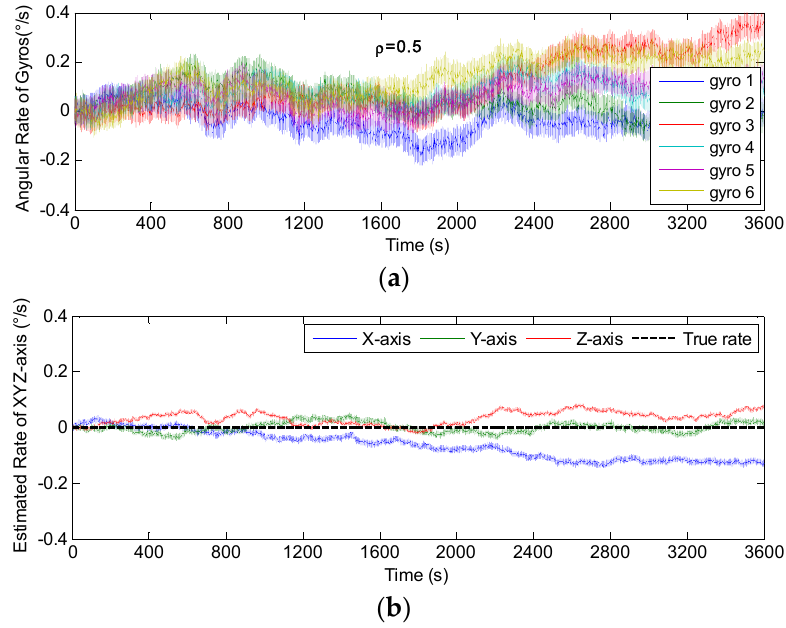
Figure 13. Fused results of 6-gyro MIMU system for scheme 1 ( ρ = 0.5). ( a ) The output of gyros. ( b ) The estimated result of the MIMU.